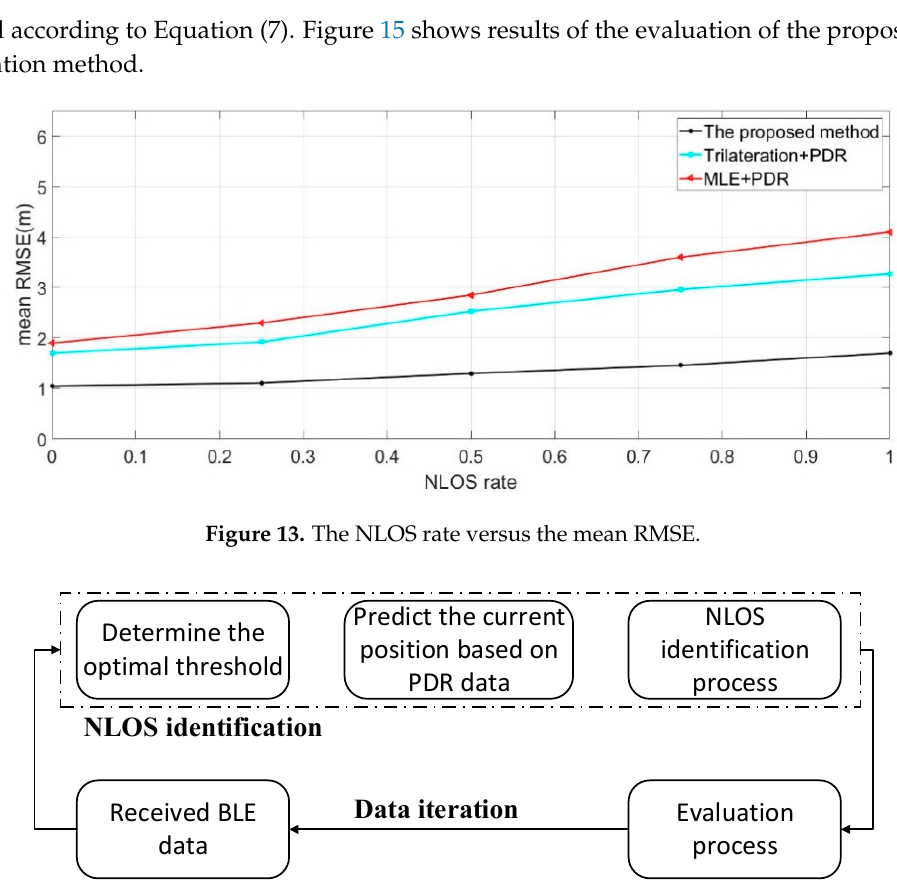
Figure 14. The procedure used for the evaluation of the proposed NLOS identification method. The red and blue points represent the BLE beacons in the NLOS and LOS propagation conditions, respectively. The points above the threshold indicate that the signals received from these BLE beacons are NLOS conditions and the points below the threshold represent the signals under the LOS conditions.